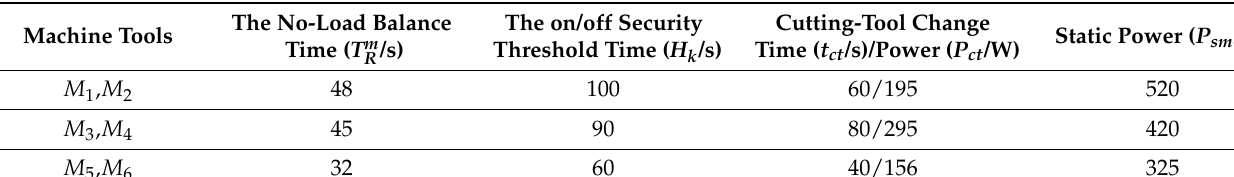
Table 5. Machine tool information.